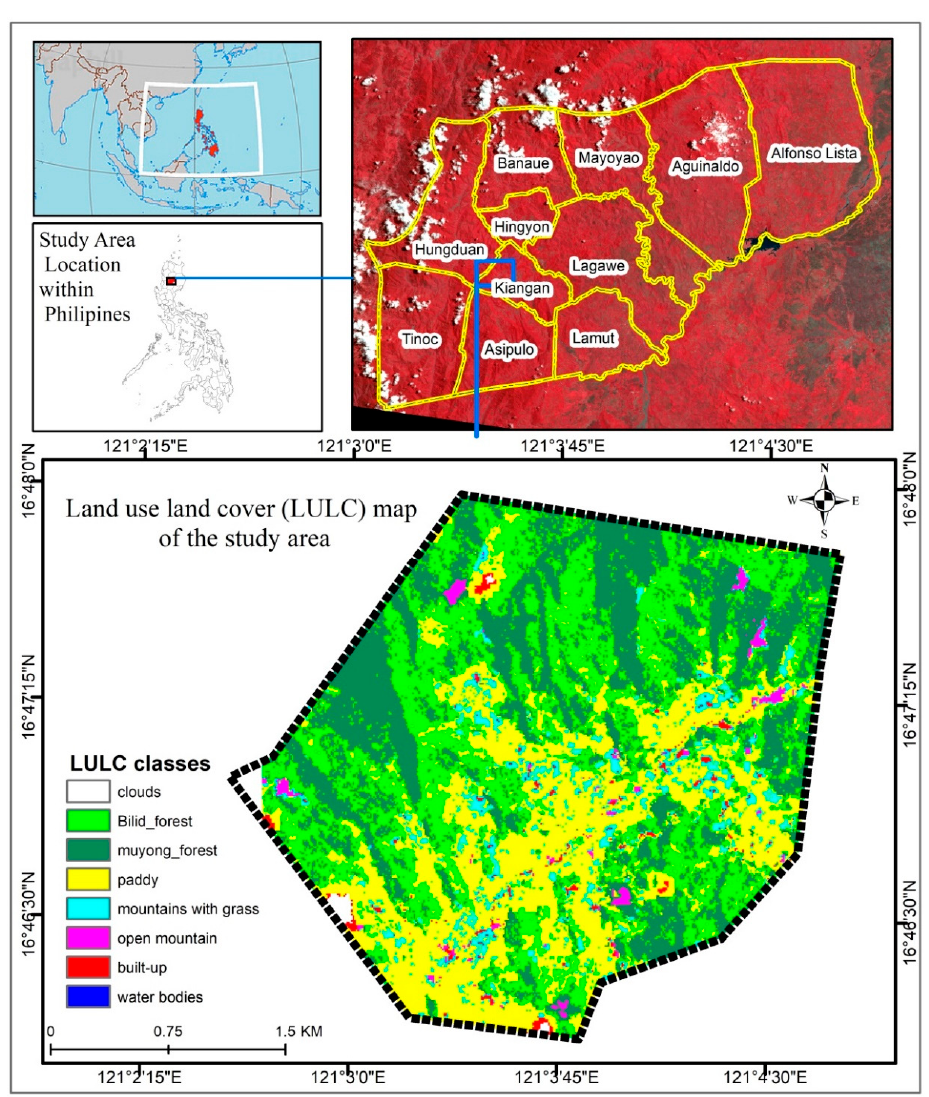
Figure 1. Location of the study area.